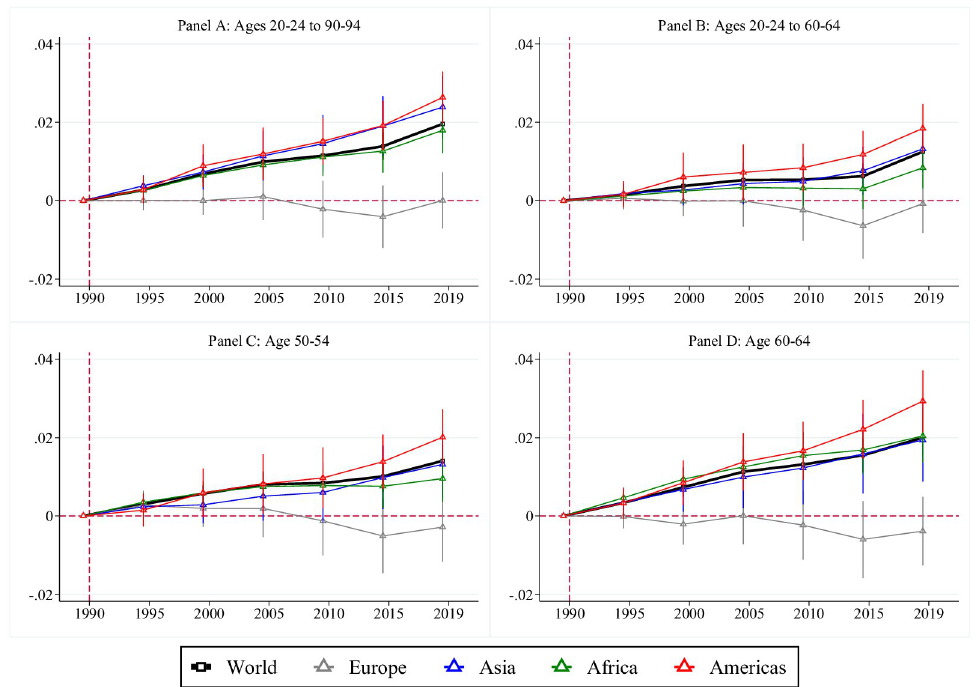
Fig 3. Physiological aging around the world. Notes: This figure plots the estimates from regressing logged deficits on period dummies (i.e., 1990, 1995, 2000, 2005, 2010, 2015, 2019), where 1990 is the omitted comparison period for all samples, along with their 95% confidence bands. Panel A includes all ages from 20–24 to 90–94. Panel B includes all working ages from 20–24 to 60–64. Panel C includes the age 50–54. Panel D includes the age 60–64.